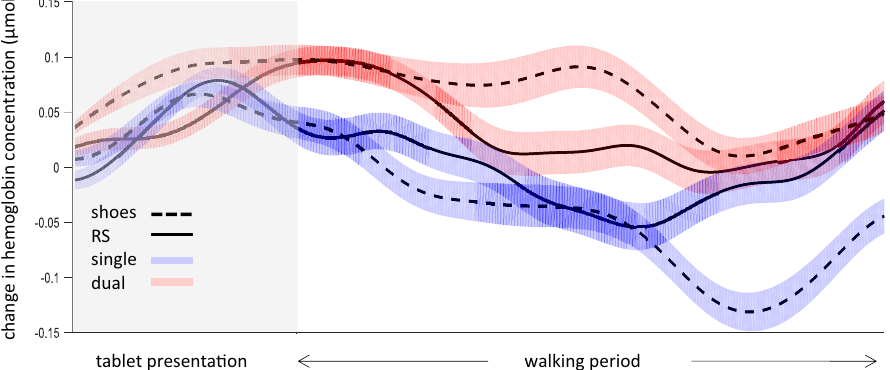
Figure 5. change in [HBO] over time under the different conditions. The shaded area represents the time at which the tablet was displayed, followed by the walking period (normalized to overcome differences in walking durations). Solid lines ( ) represent the mean response for the RS condition and dashed lines ( ) for the shoes condition. Blue color ( ) represents the single task condition, and red ( ) the dual task condition. *Due to the normalization procedure, some temporal shifting might have